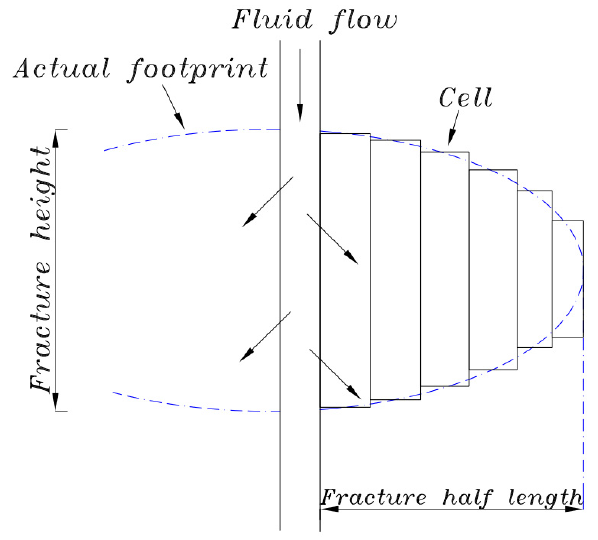
Figure 9. Schematic of cell-based P3D fracture extension: the fracture extension range is divided into multiple rectangles within the range of an ellipse.